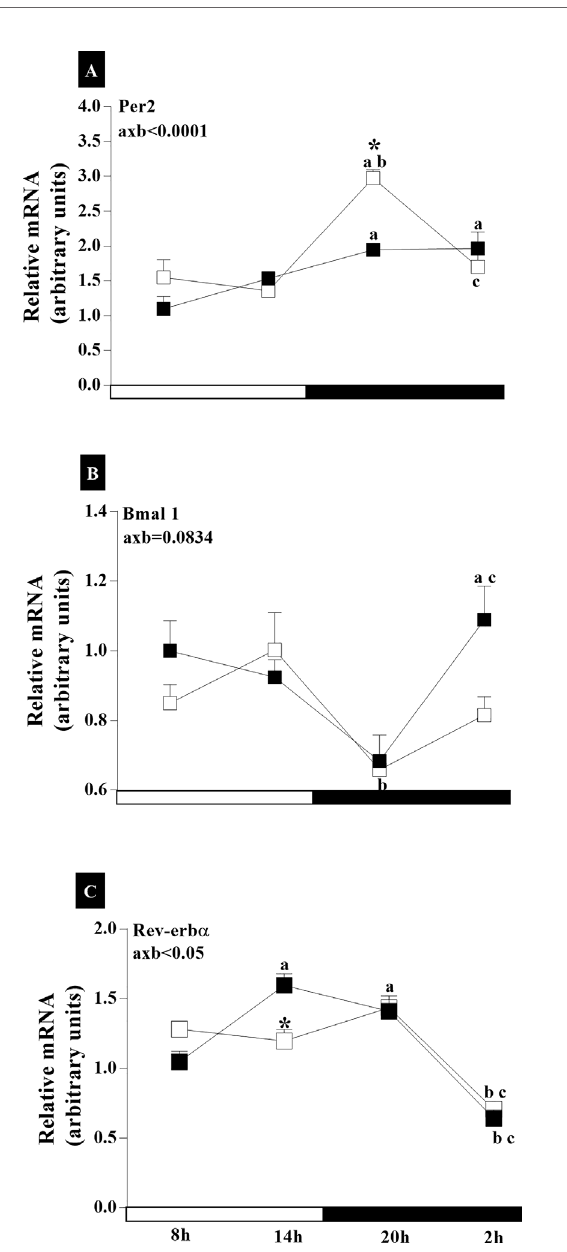
FIGURE 5 | Daily oscillations in relative mRNA expression for Per2 , Bmal1 , and Rev-erb a in the preoptic area. Light and dark phases are represented along the X-axis by their respective schedules. Beginning of the light phase at 07:00, when the lights are turned on. The dark phase started at 19:00. All samples were collected at six-hour intervals after the fi rst hour (i.e., 08:00), for 24 h. Light/dark cycle = 12/12 h. (A) Relative temporal expression of mRNA for Per2 , (B) Bmal1 , and (C) Rev-erb a in animals with a regular cycle on diestrus day and irregular cycle in persistent diestrus. * indicates intergroup variation at the same time: ( ■ ) Regular estrous cycle on diestrus day × ( □ ) Irregular cycle in persistent diestrus. Letters indicate temporal variation within the group. a vs. 8:00; b vs. 14:00; and c vs. 20:00. axb = age and time of day interaction. n = 3 – 7; Replicates with a variation above 0.2 were automatically excluded from the groups. DD Ct for Per2 and Rev-erb a ; relative standard curve for Bmal1